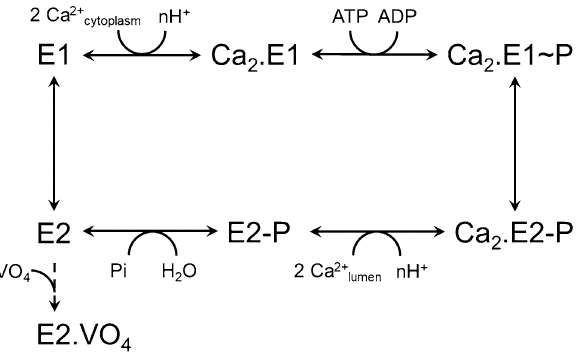
Figure 1. SERCA1a reaction cycle. Scheme shows the main steps for substrates binding and dissociation. At physiological pH, two cytoplasmic calcium ions bind to the “E1” high-affinity states. Binding of one Mg.ATP triggers calcium occlusion and allows autophosphorylation on the catalytic aspartate localized in P-domain (“Ca 2 .E1 ~ P” occluded state). The energy transferred from the nucleotide to the protein allows large conformational changes necessary for transport sites reorientation towards the lumen and then, for releasing of calcium ions against a concentration gradient. Protonation of the transport sites and autodephosphorylation of the Ca 2+ -free “E2-P” state enable cycling of the enzyme. Note that ATP can bind to most of these intermediates to act as a positive modulator and to accelerate transitions 1 . Orthovanadate (VO 4 ) can act as an inhibitor after binding to the E2 ground